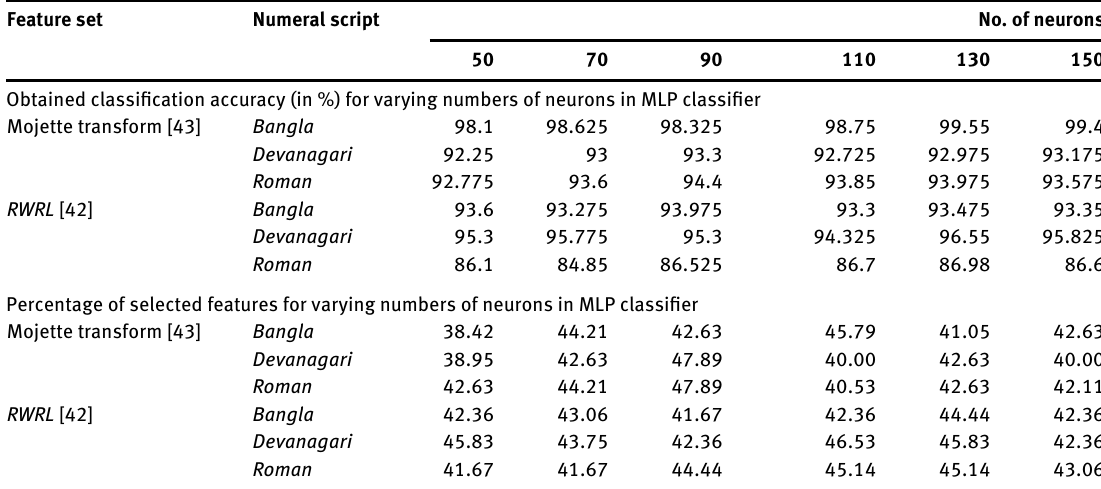
Table 5: Effect of Change in Number of Neurons in the Hidden Layer of MLP Classifier with (a) Classification Accuracy of Selected Features and (b) Percentage of Features Selected in E1.